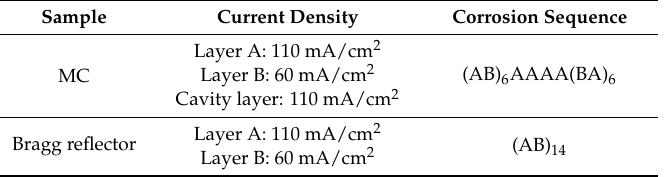
Table 1. Experimental parameters of PSiMC.